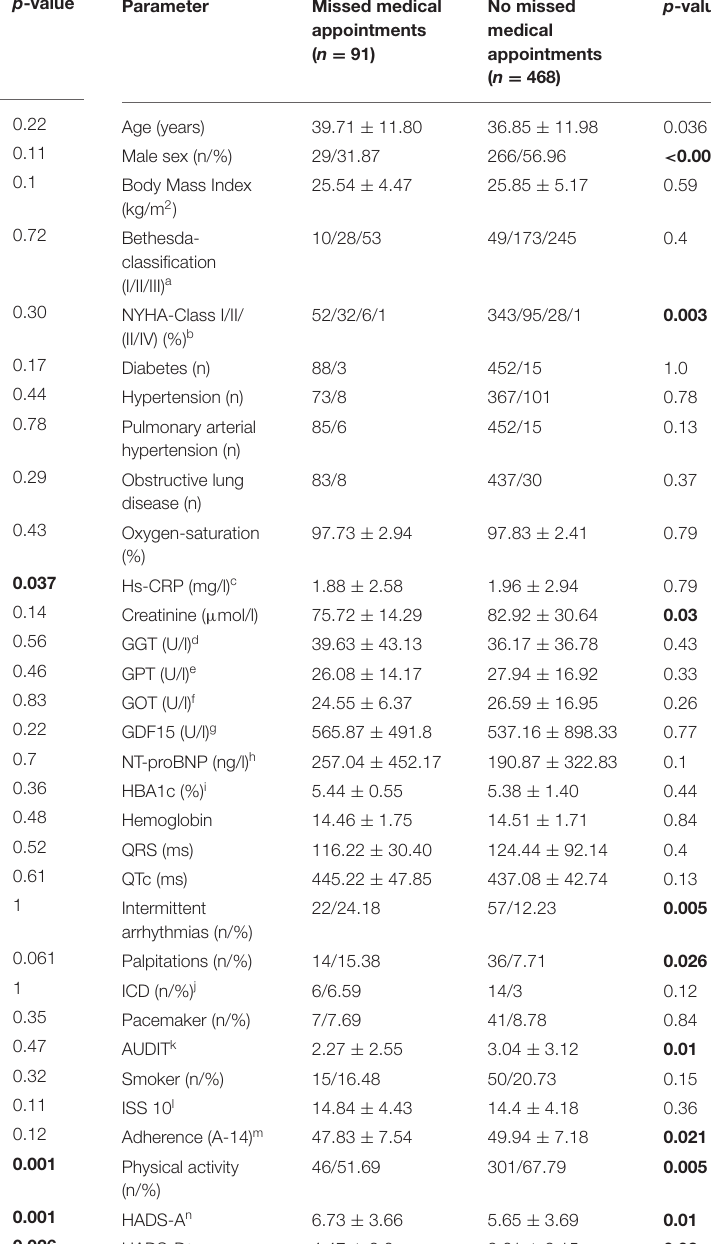
TABLE 3 | Clinical characteristics, demographic, psychiatric, lifestyle and laboratory data of patients’ cohort, either keeping or postponing at least one medical